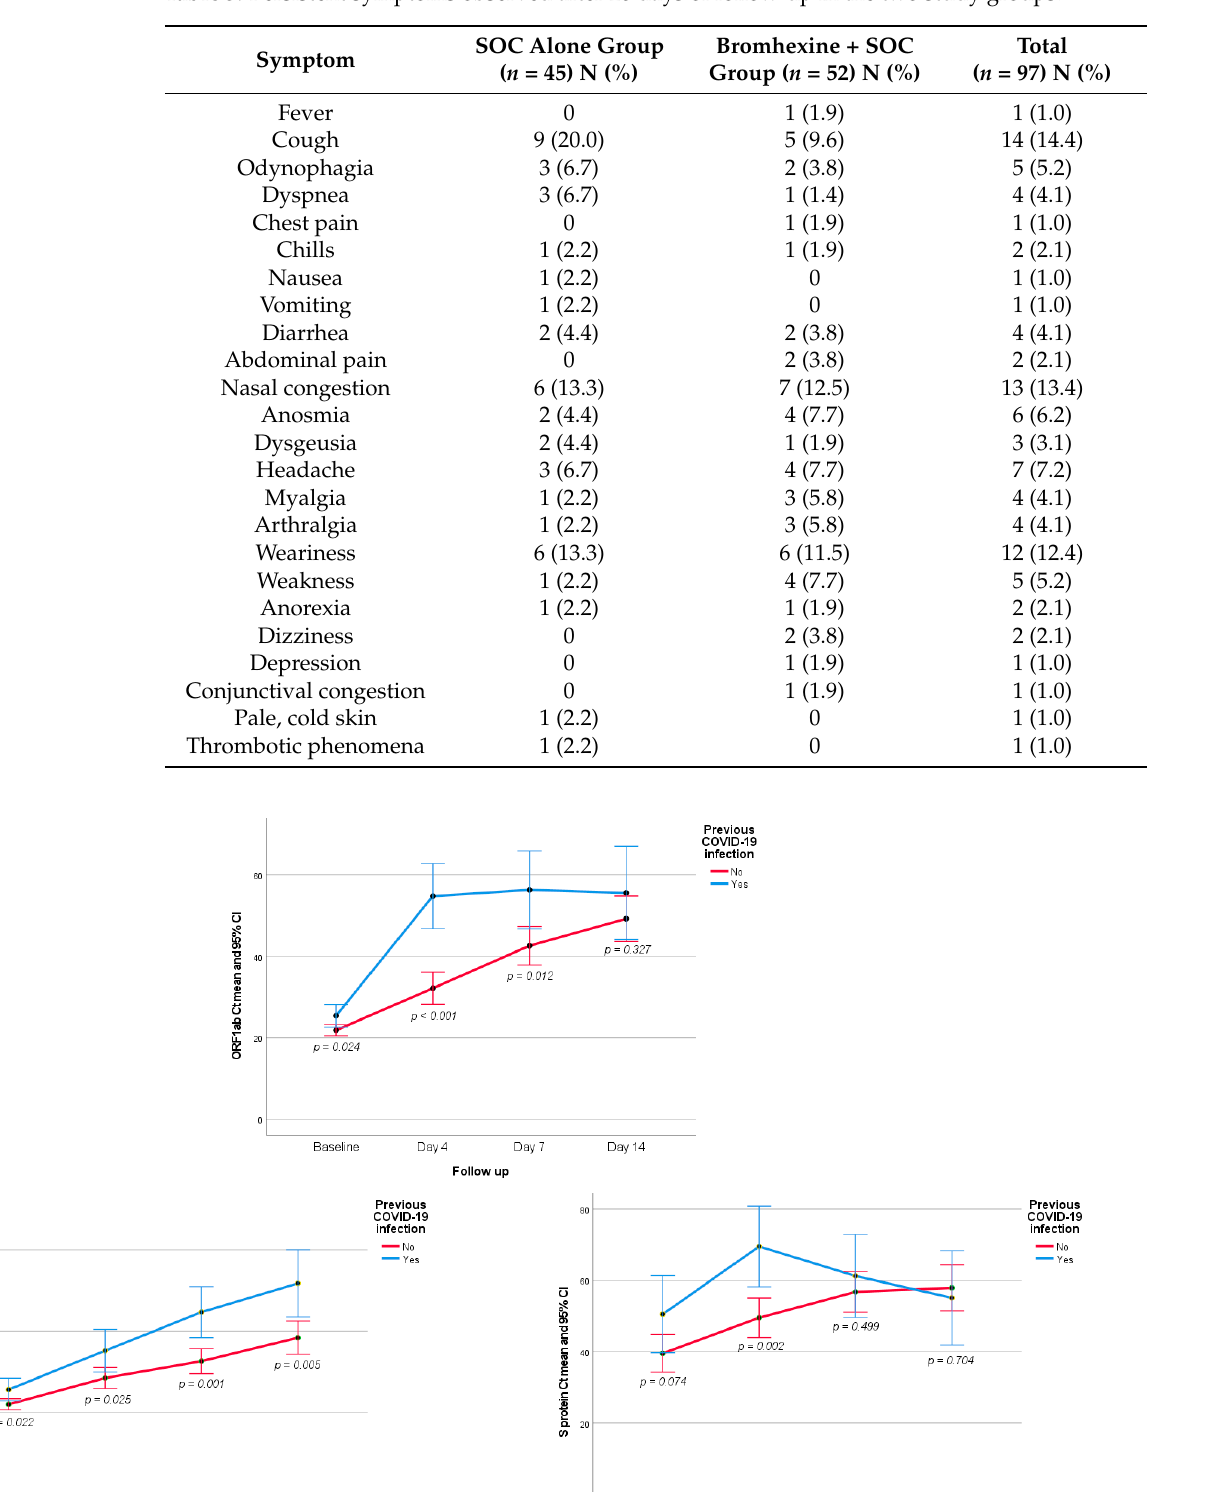
Table 3. Persistent symptoms observed after 28 days of follow-up in the two study groups.